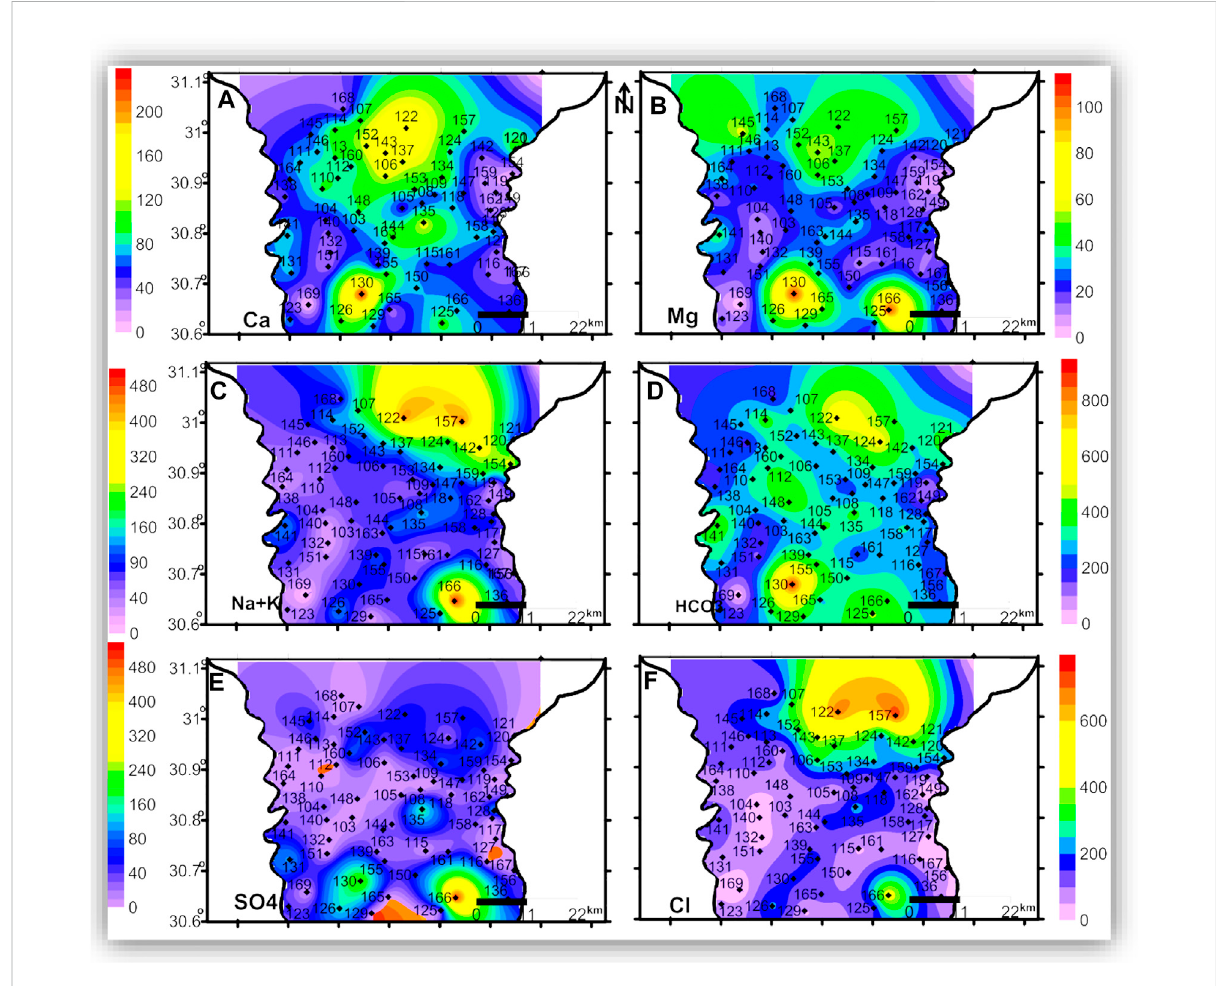
FIGURE 8 The spatial distribution maps of the major ion concentrations (mg/l) of the groundwater samples in the deep